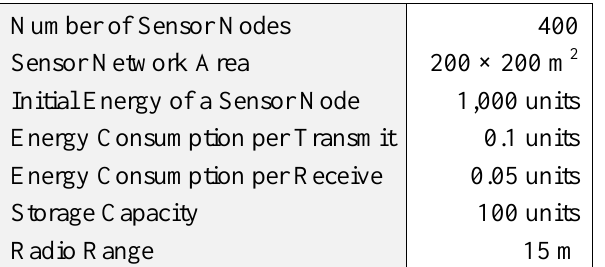
Table 1. Parameters for performance evaluation.